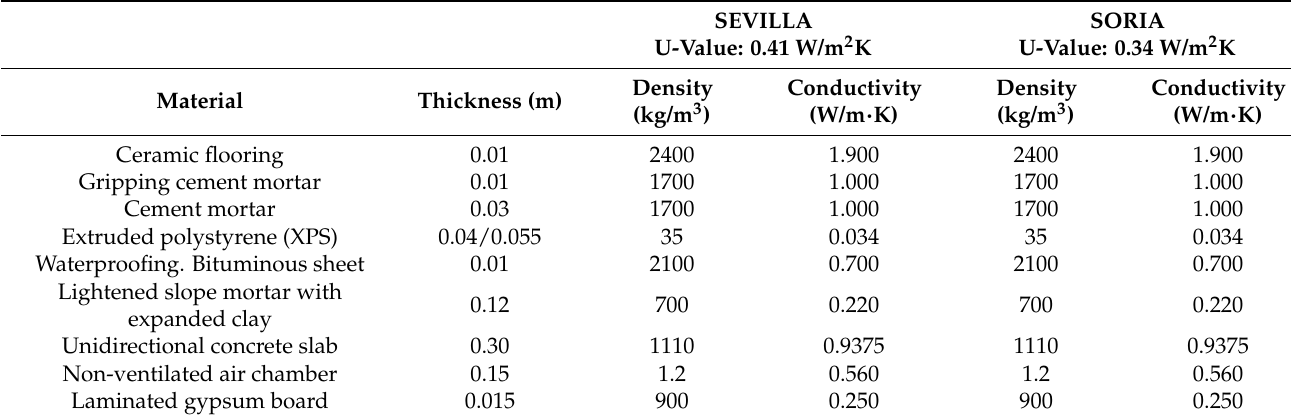
Table 3. Characteristics of the construction system in the flat roof.